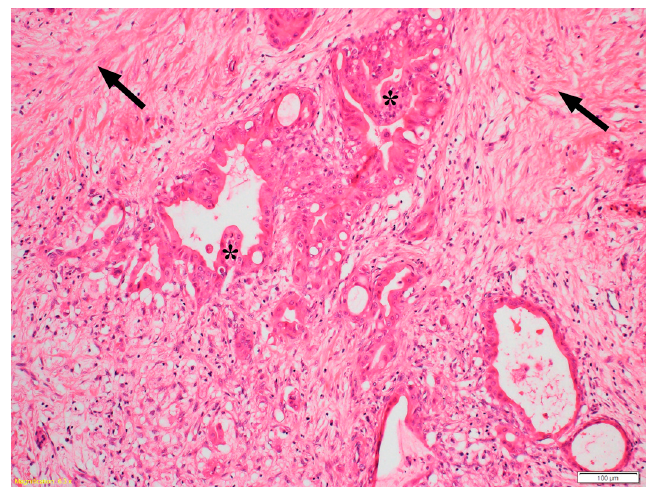
Figure 1. Representative photomicrograph of haematoxylin & eosin stained human pancreatic cancer section showing malignant elements (duct-like and tubular structures-indicated by asterisks) embedded in a highly fibrotic stromal reaction (indicated by arrows). Reprinted with permission from Elsevier [4].